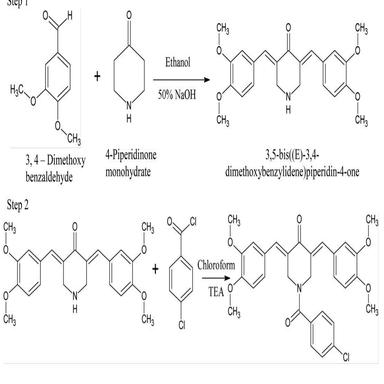
REACTION SCHEME OF CDMBP